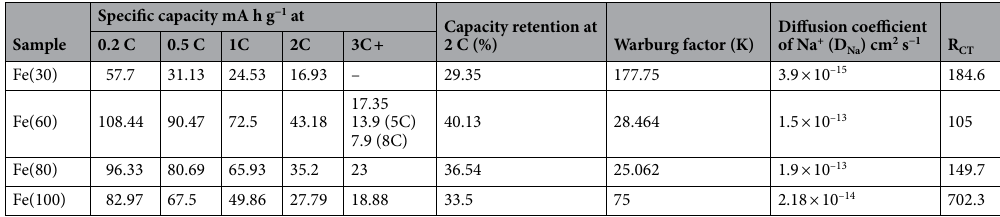
Table 4. Specific capacities of microwave prepared samples at different current rates.